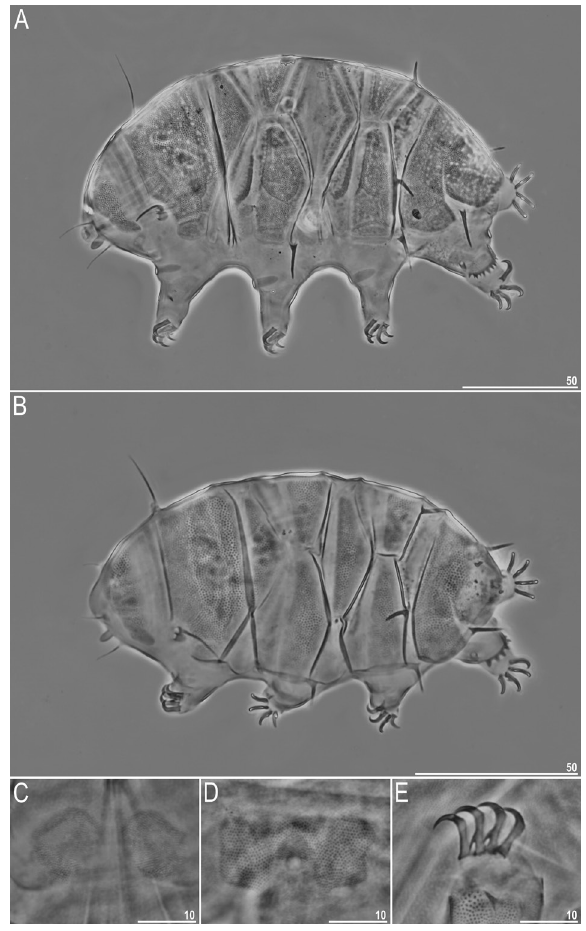
Figure 1. Morphology of Echiniscus masculinus sp. nov. (PCM). A. Adult female (holotype, dorsolateral view); B. Ju- venile (paratype, dorsolateral view); C. Subcephalic plates; D. Genital plates enclosing male gonopore; E. First leg pair with claws and spine I. All scale bars in